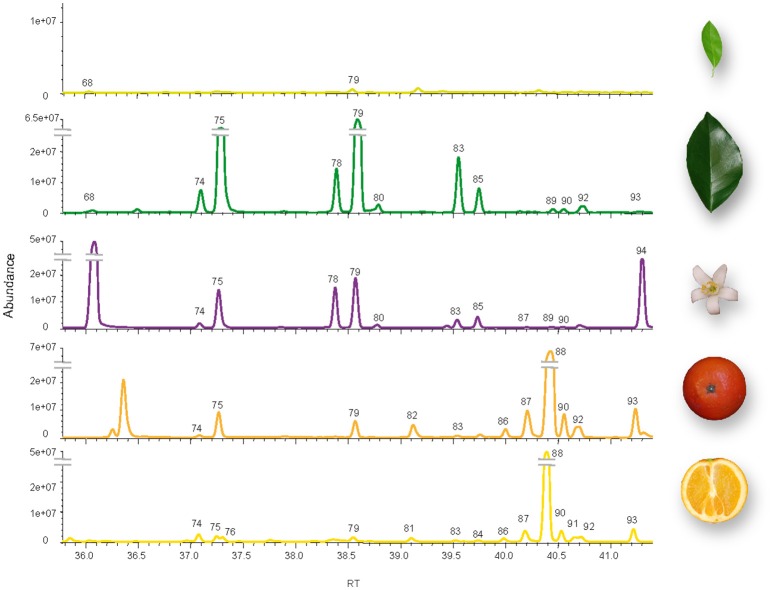
Volatile sesquiterpenes emitted by different tissues of Pineapple sweet orange. From top to bottom, young flushes, mature leaves, flowers, peel, and pulp from mature fruit. Peak numbers were assigned in basis of retention time (Supplementary Table 2), and those displayed in this figure correspond to: (68), α-cubebene; (74), α-copaene; (75), β-elemene; (76), β-cubebene; (78), (Z)-β-farnesene; (79), β-caryophyllene; (80), β-cedrene; (81), allo-aromadendrene; (82), γ-gurjunene; (83), α-humulene; (84), γ-selinene; (85), α-farnesene; (86), 3,7(11)-selinadiene; (87), β-selinene; (88), valencene; (89), eremophilene; (90), α-selinene; (91), δ-selinene; (92), β-cadinene, (93), α-panasinsene, and (94), (±)-trans-nerolidol.